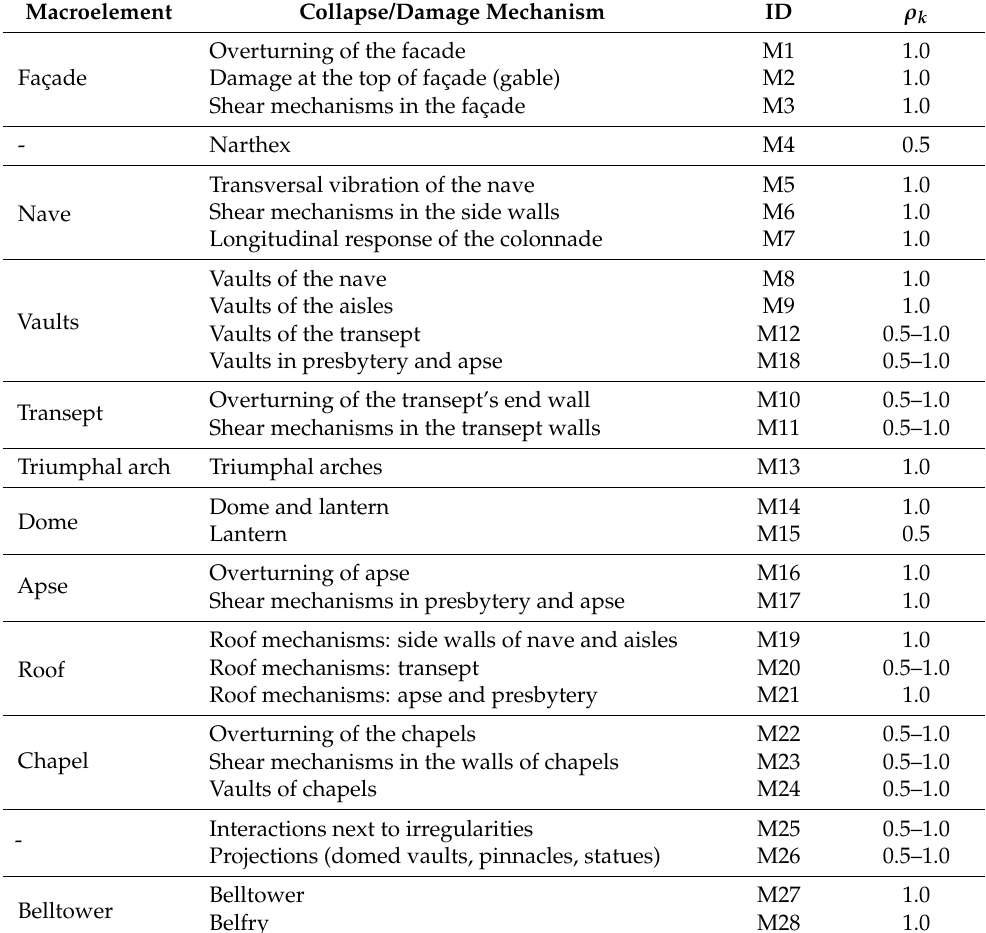
Table 1. Possible mechanisms considered for each macroelement of the